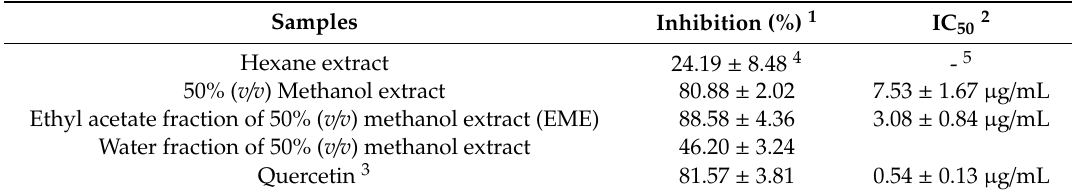
Table 1. The rat lens aldose reductase (RLAR) inhibitory activities of extracts and fractions from the seeds of Oenothera